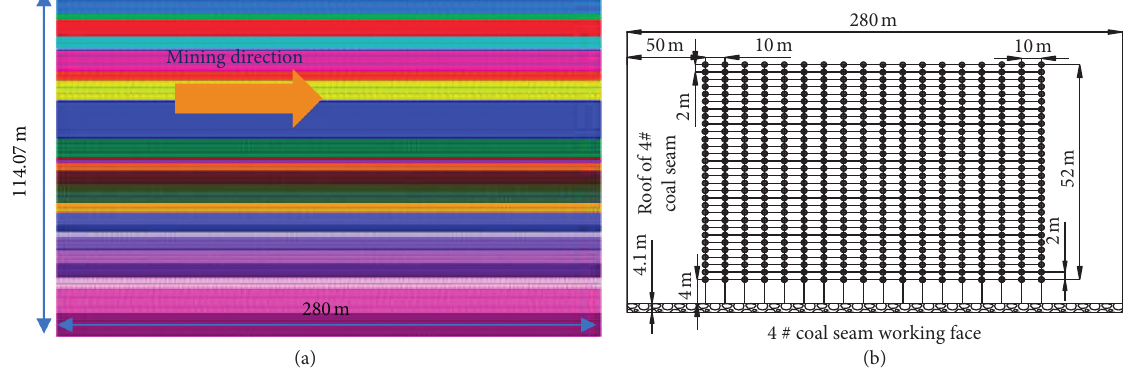
Figure 9: 3DEC numerical simulation. (a) 3DEC numerical model. (b) Layout of measuring points in the model.